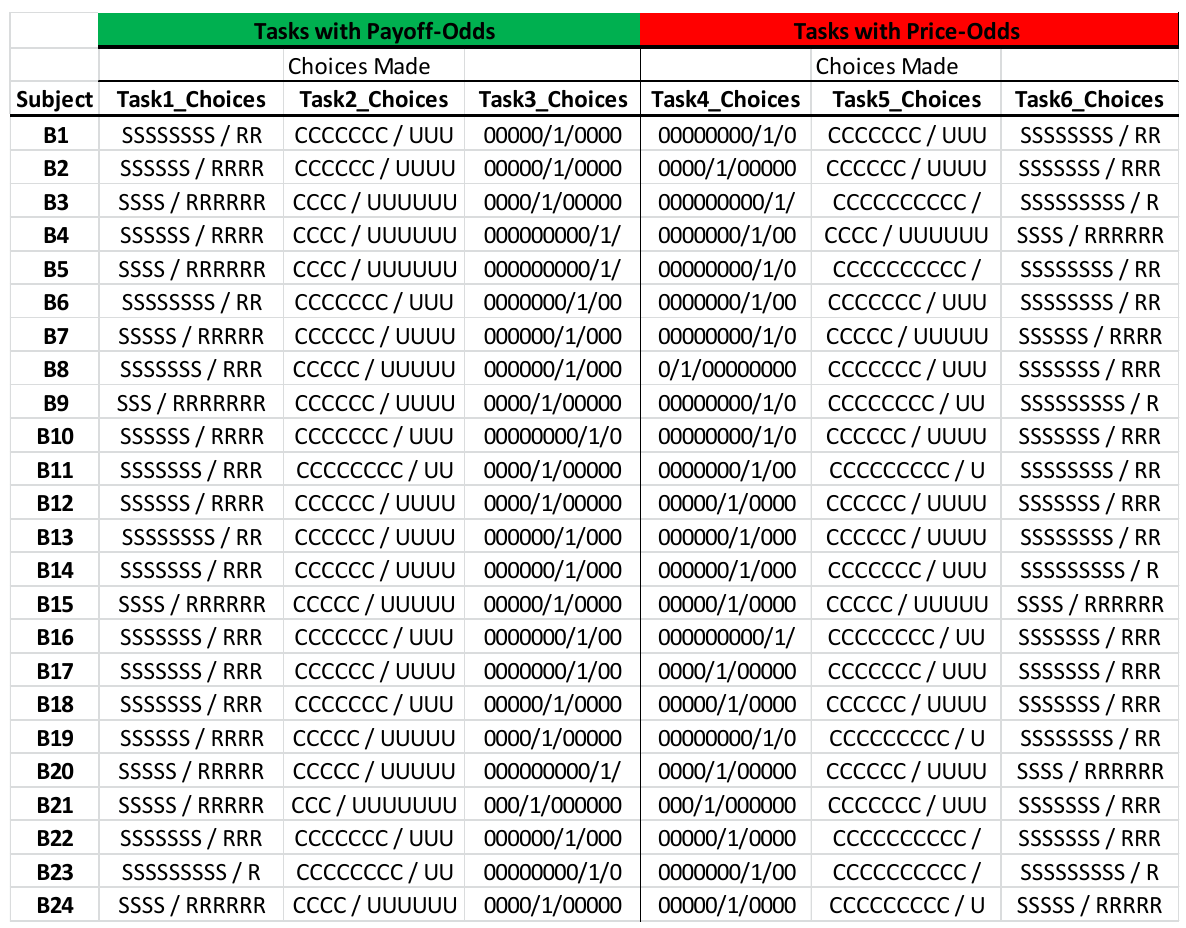
Figure A10. Individual lottery choice decisions—Session B. Table A11. Risk aversion classifications based on chosen options.